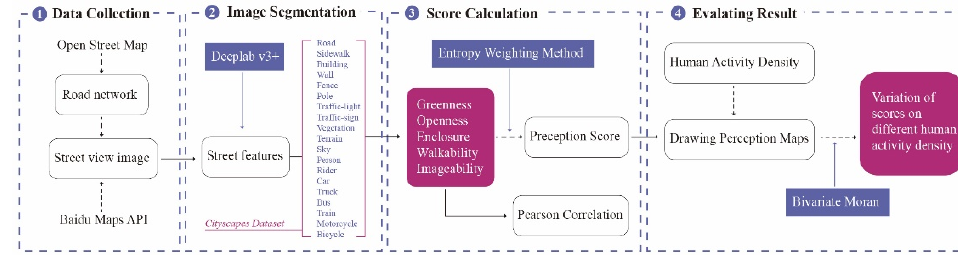
Figure 5. Analytical framework used in this study.